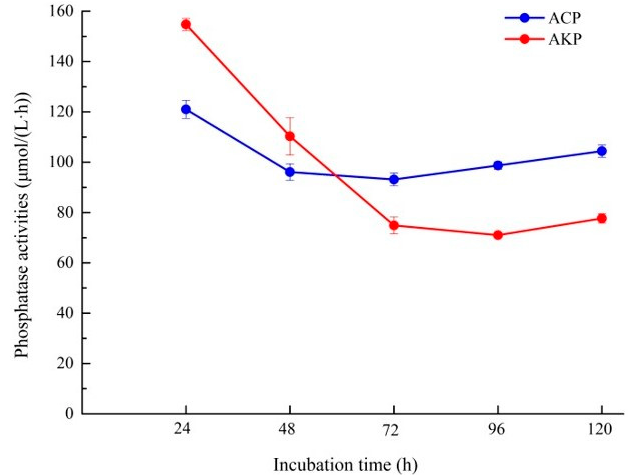
Figure 6. Phosphatase activity of fungal isolate L4. ACP, acid phosphatase; AKP, alkaline phospha ‐ tase.